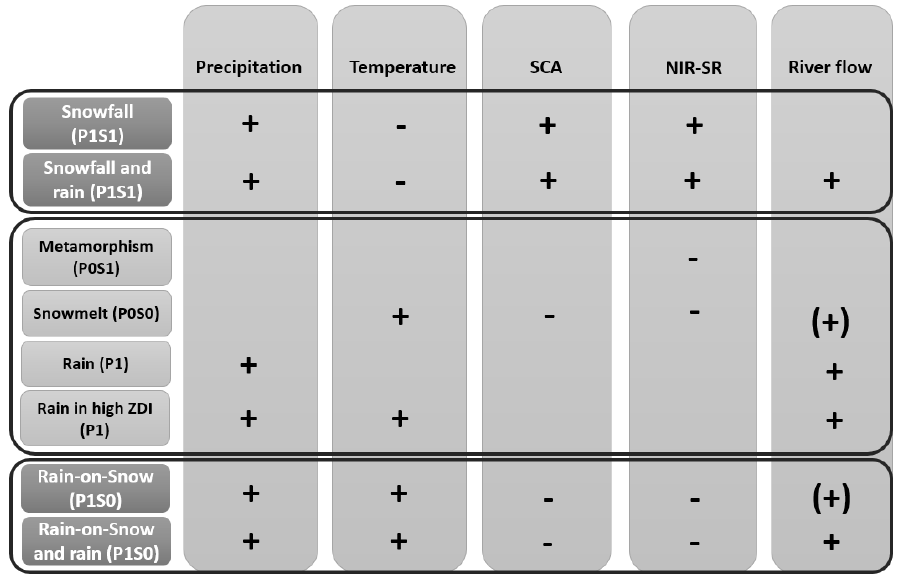
Figure 3. Events based on precipitation and SCA/NIR-SR response with temperature and river-flow